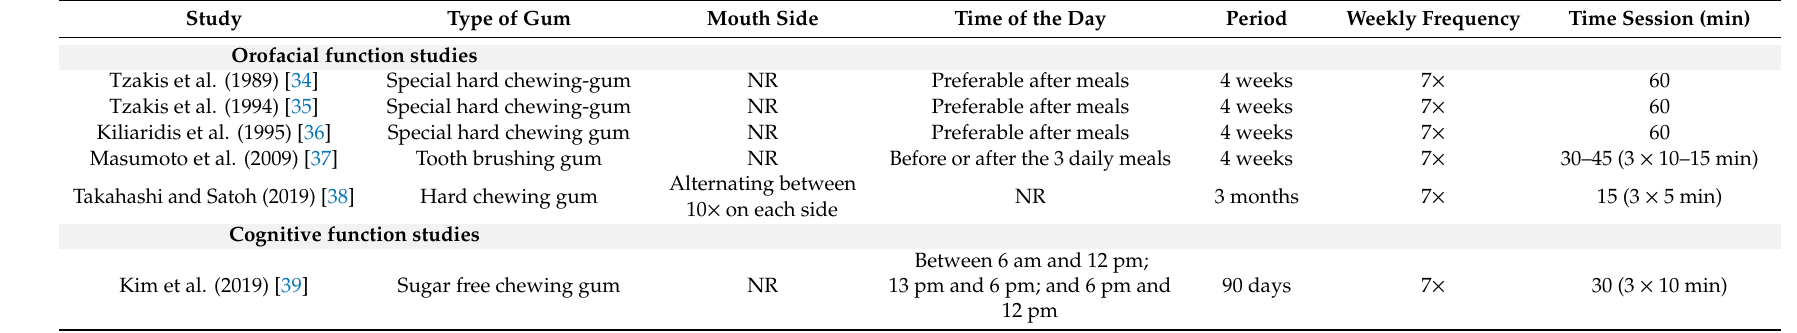
Table 2. Characteristics of the chewing intervention performed by healthy participants in the included